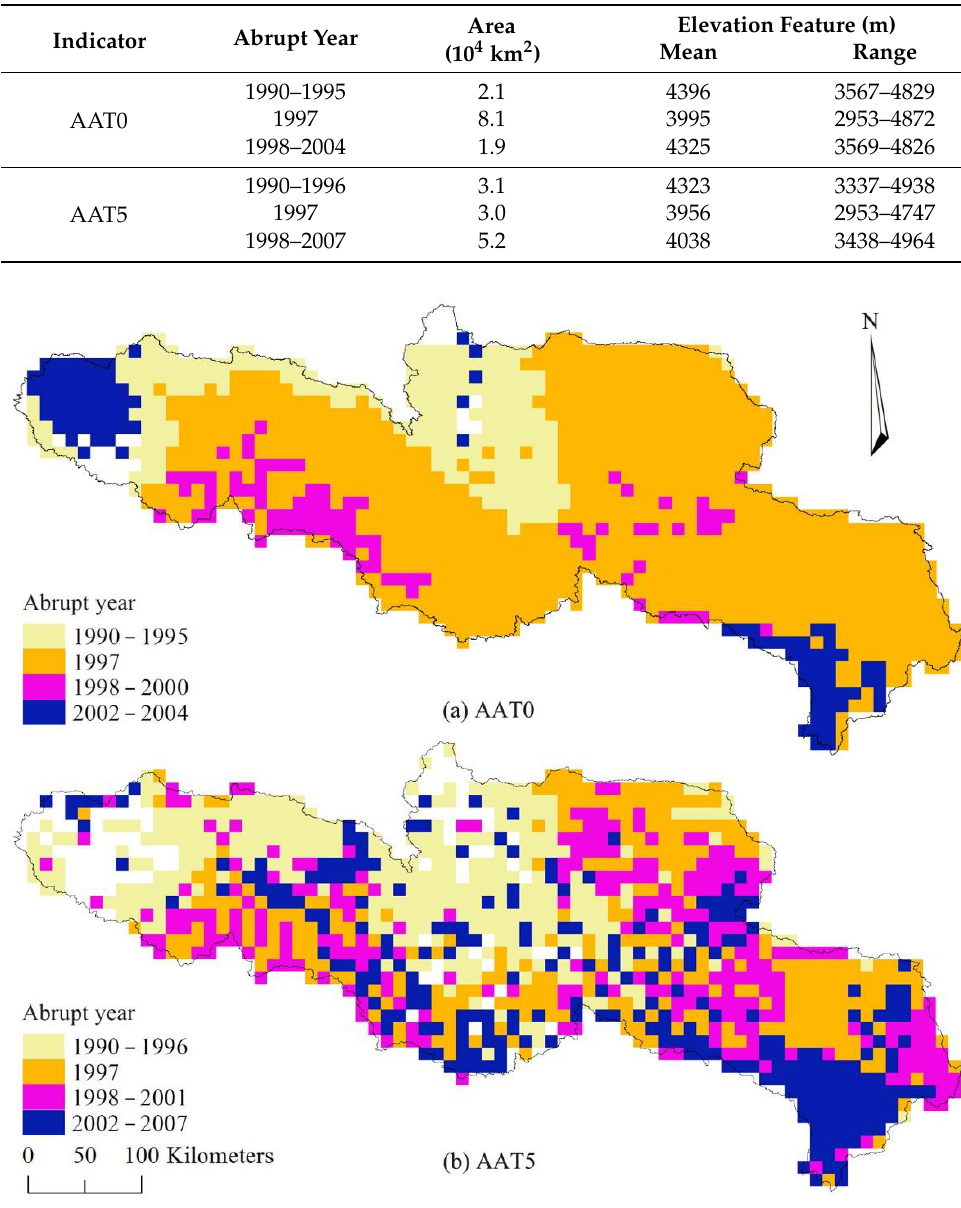
Figure 7. The distribution of the abrupt year of ≥ 0 °C ( a ) and ≥ 5 °C ( b ) annual accumulated temperature during 1979–2018 in the source region of the Yellow River.